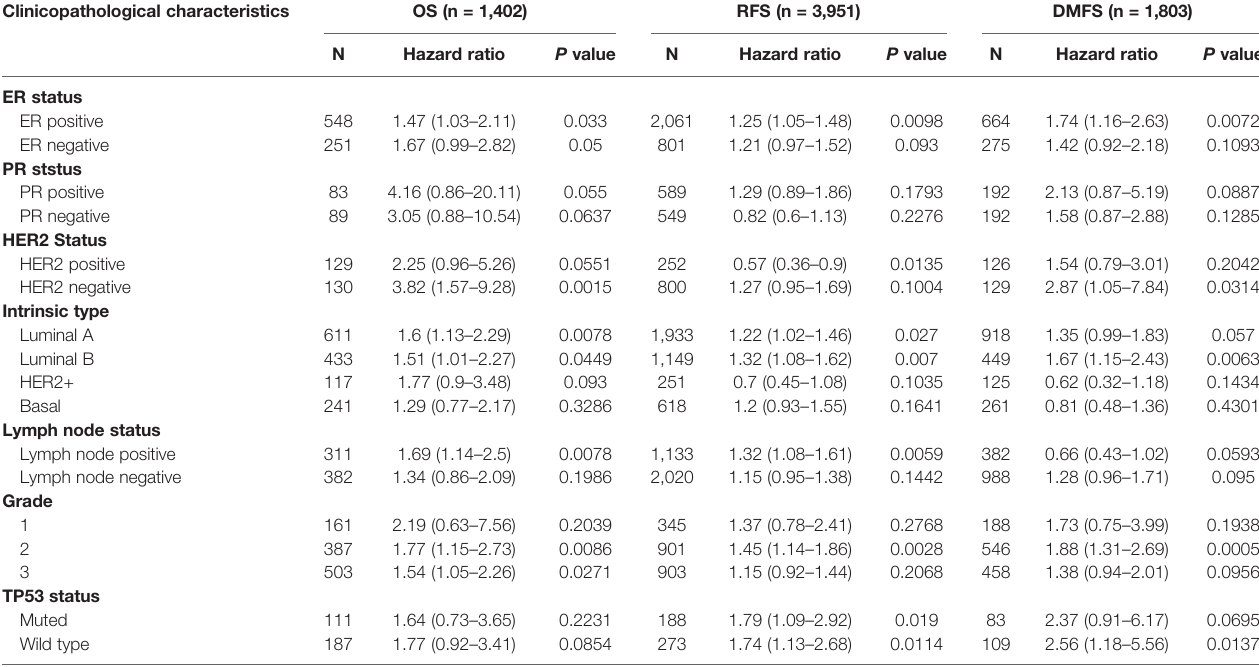
TABLE 2 | The correlation between SPINT2 expression and prognosis in breast cancer patients with different clinicopathological parameters. Clinicopathological